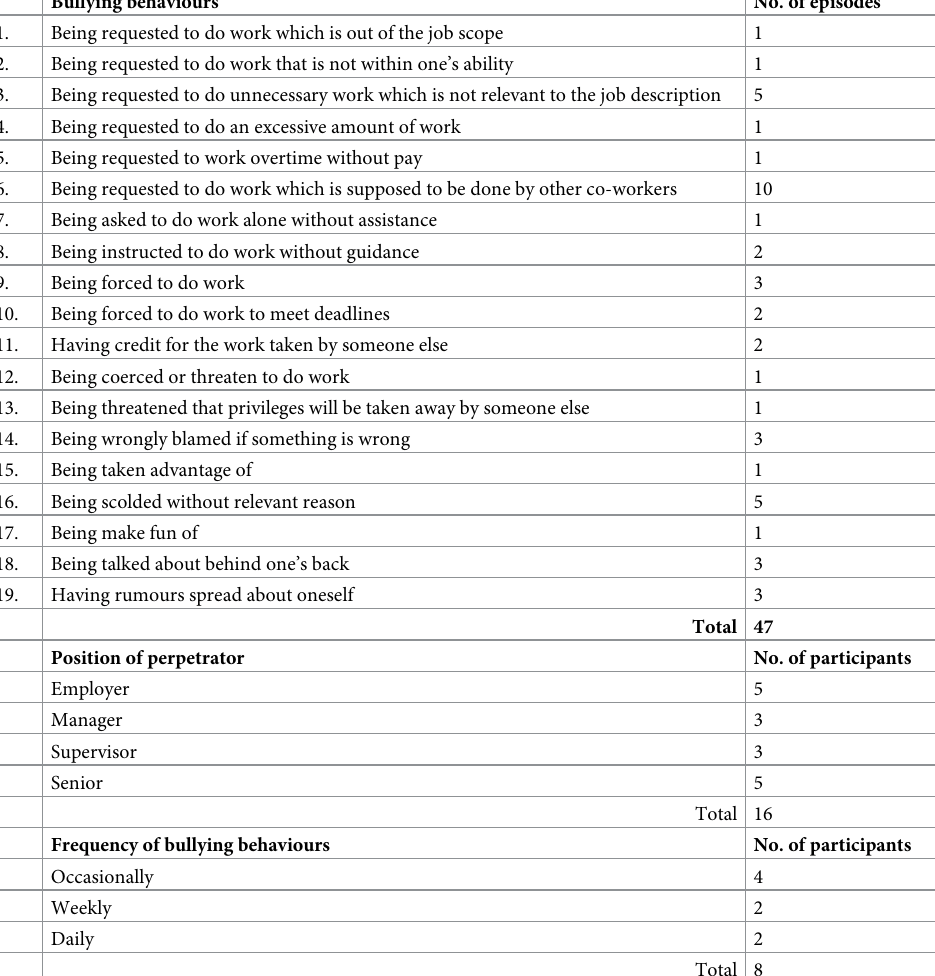
Table 1. Number of bullying episodes, positions of perpetrators and frequencies of bullying behaviours according to current targets and witnesses. Bullying